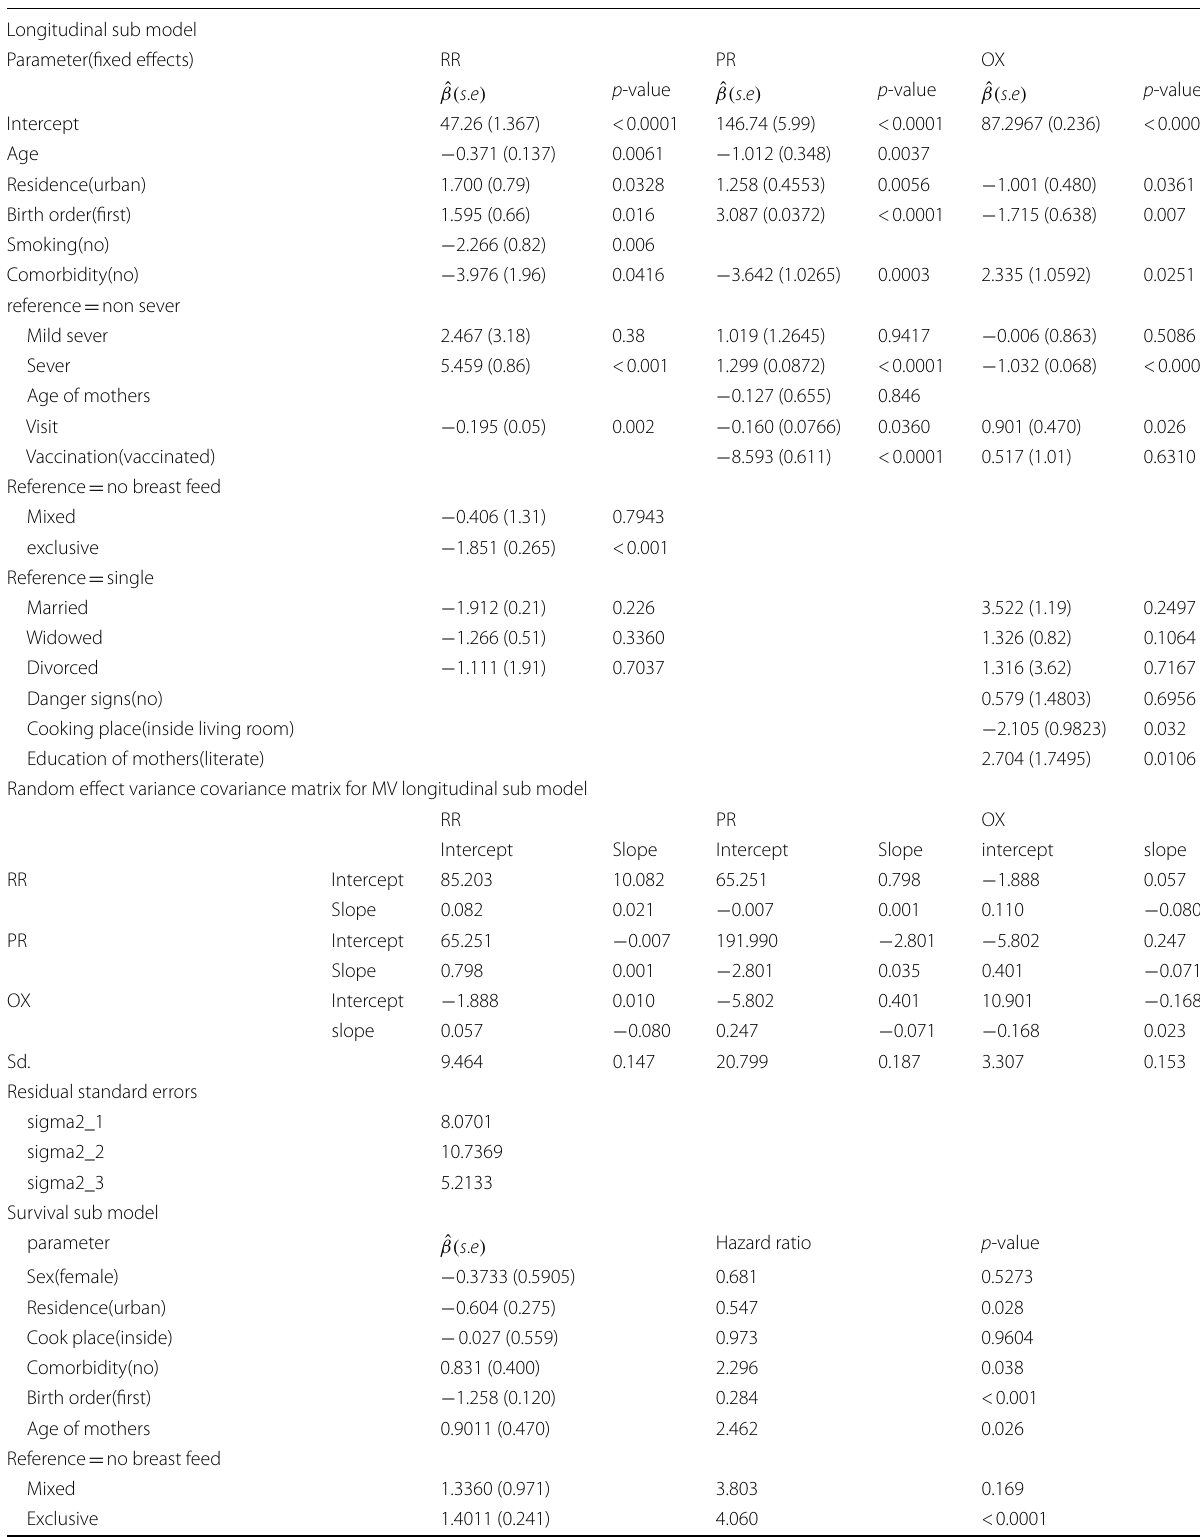
Table 4 Results of joint model of multivariate longitudinal model and cox PH model Longitudinal sub